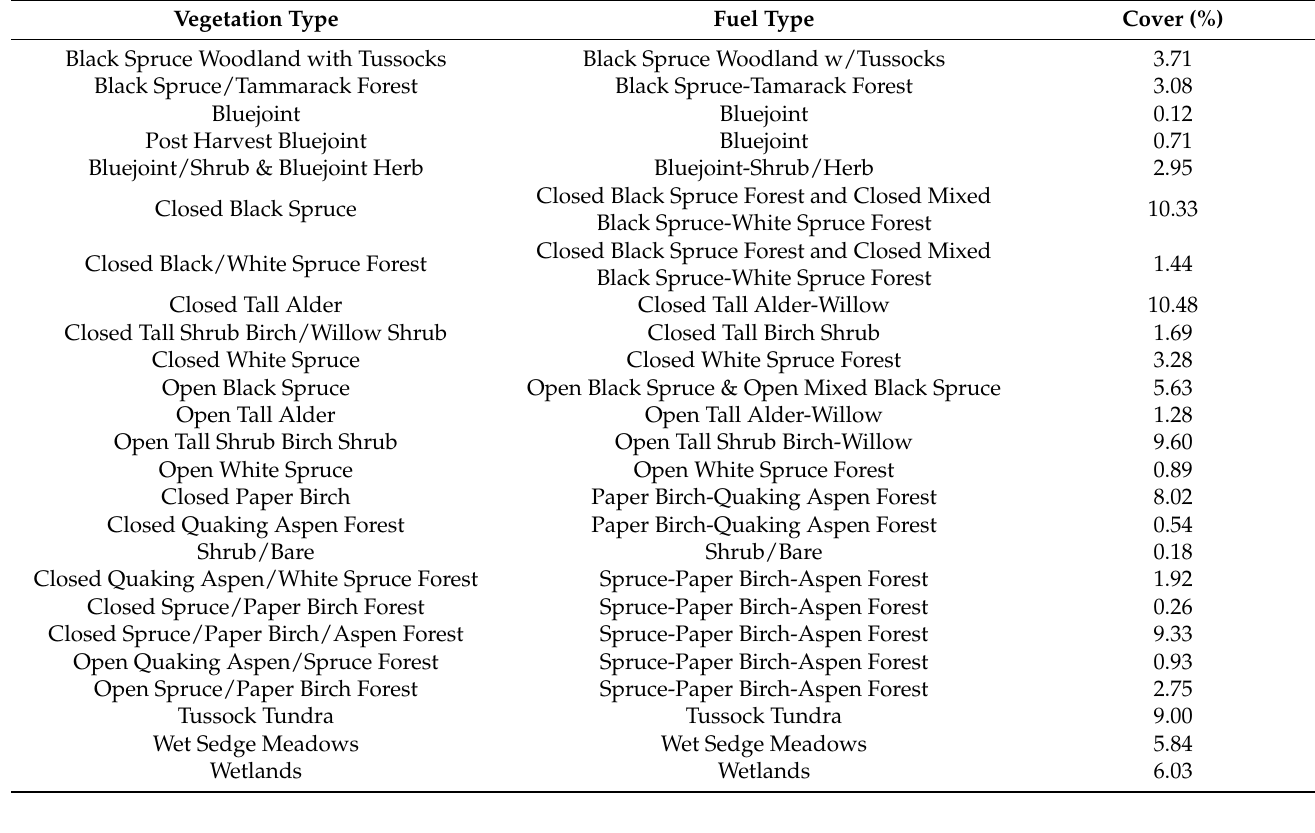
Table 1. A list of vegetation types (fuel types) and their area percent cover mapped from AVIRIS-NG 304 band image at BCEF.